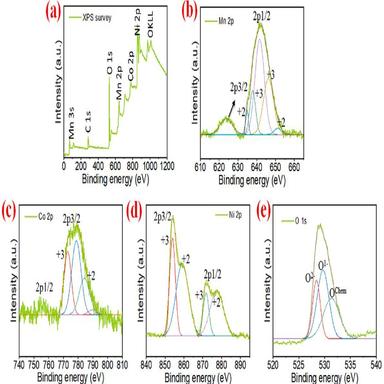
(a) XPS survey spectrum and (b–f) High-resolution Co 2p, Mn 2p, Ni 2p, and O 1 s XPS spectra for Ni-Co/CoMn2O4 composites on Ni form.